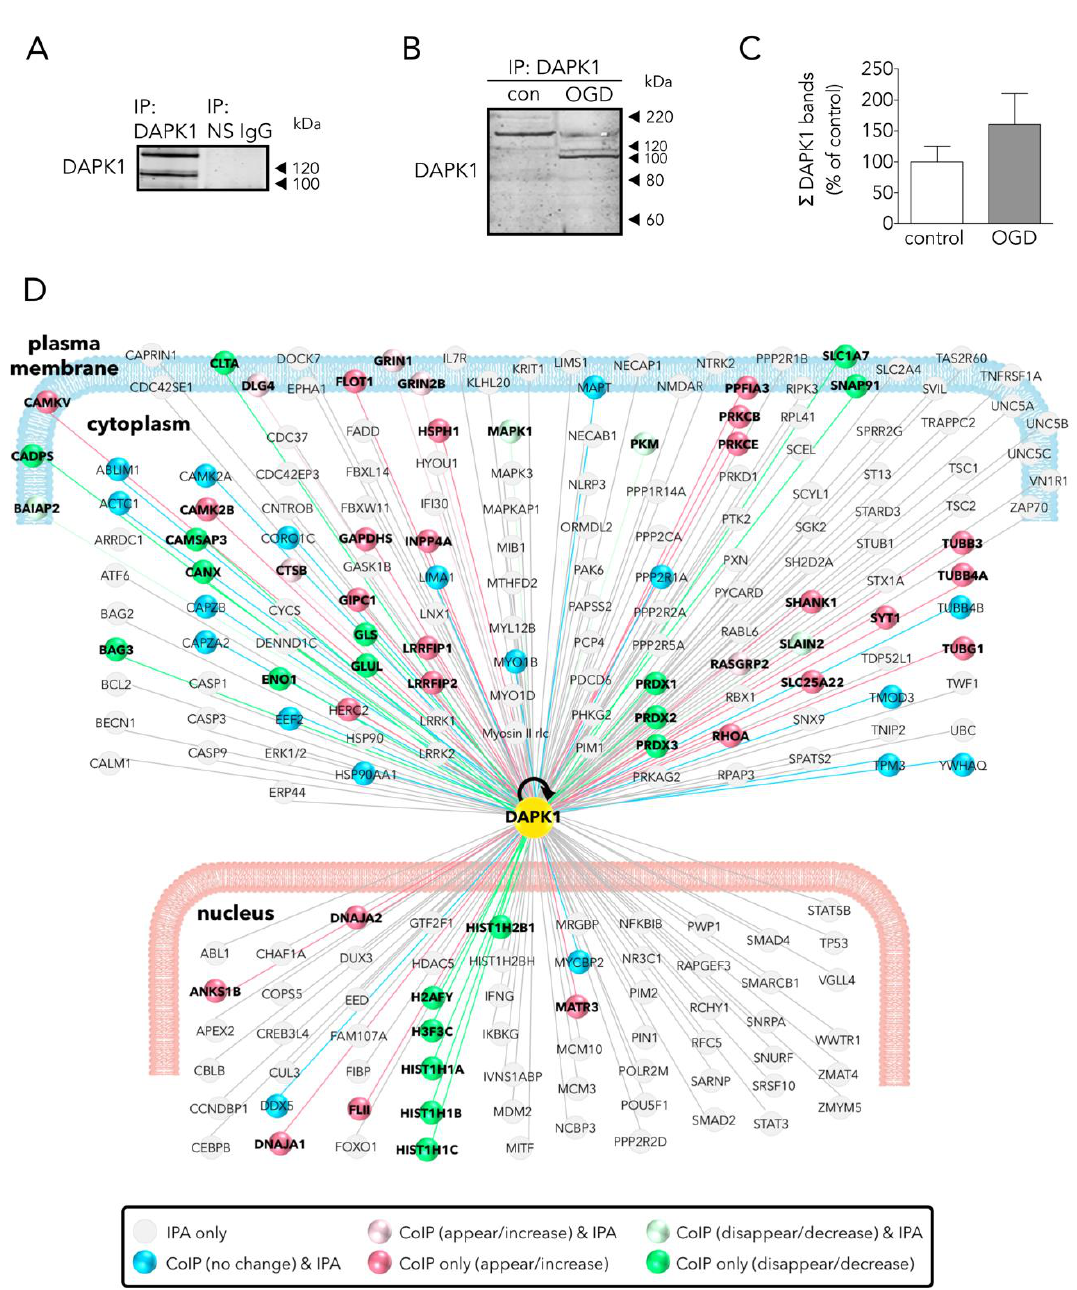
Figure 2. Main effects of OGD on the neuronal DAPK1 interactome. ( A ) WB shows that DAPK1 immunoprecipitates using a specific anti-DAPK1 antibody (IP: DAPK1, left lane), but it does not when using a non-specific antibody (IP: NS IgG, right lane). ( B ) WB showing the effect of OGD on the DAPK1 bands obtained by immunoprecipitation. ( C ) Graph showing the amount of DAPK1 obtained after immunoprecipitation of control and OGD samples ( t test, n = 3 independent primary neuron culture preparations, with 3 technical replicates each). Note that, in this graph, differently than in WB in Figure 1B, DAPK1 data represent protein co-immunoprecipitated from neurons. ( D ) Drawing depicting some of the DAPK1 interactors found in the present study and those present in the IPA database; color codes of proteins are self-explained in the legend within the drawing. Results are shown as the mean and SEM.